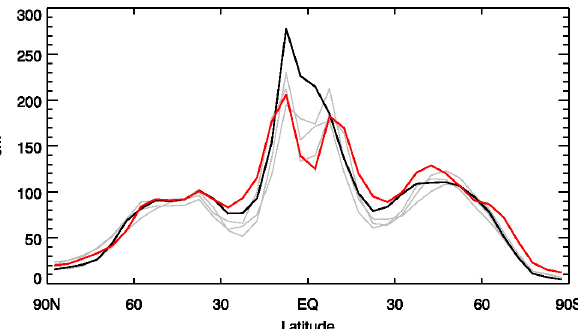
Fig. 6. Zonal averaged annual precipitation for observations (black), GENMOM (red) and three IPCC AR4 models (gray). The IPCC AR4 models are averaged over the last 30 years (1970–1999) of the Climate of the 20th Century experiment.